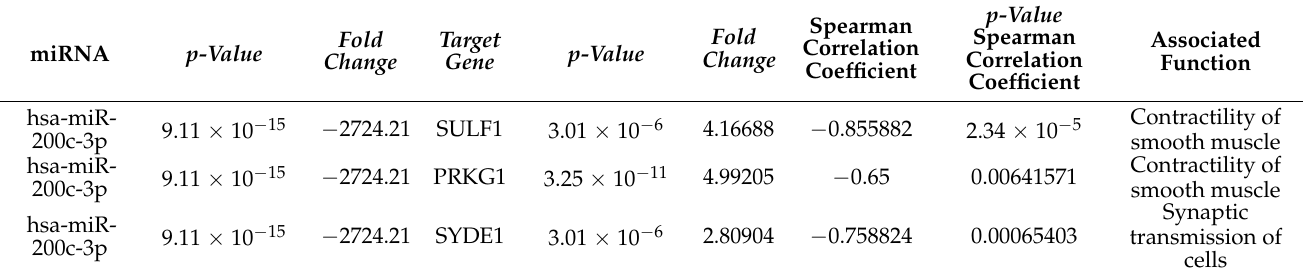
Table 1. Indirect associations between PRKG1 , SULF1 , and SYDE1 genes and differentially expressed miR-200c-3p without prior knowledge of the